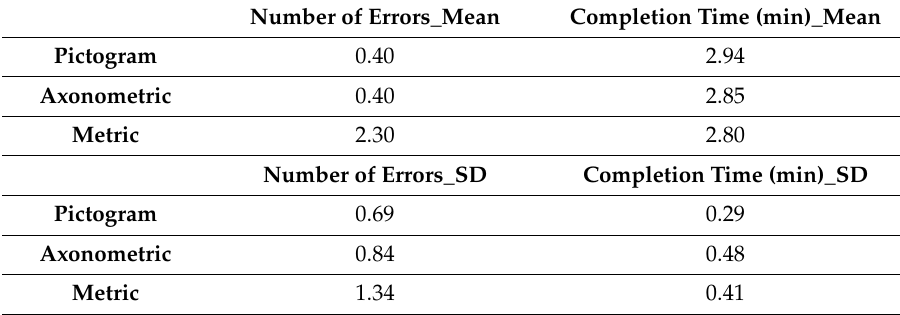
Table 6. Descriptive statistics for number of errors and completion